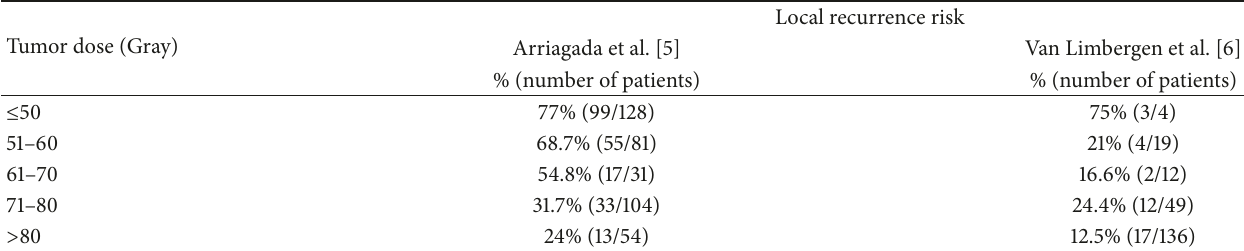
Table 1: Local recurrence risk and tumor